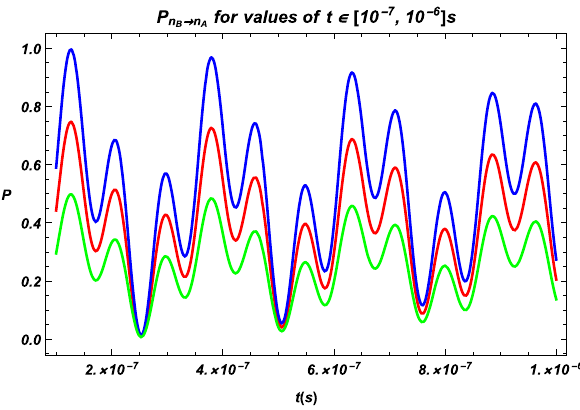
Fig. 1 Plots of P B → A ( t ) , for θ = π/ 3 (the red line), θ = π/ 4 (the blue line), θ = π/ 8 (the green line). In the plots, we con- sider n = 4 trapped ions in a harmonic potential, and the follow- ing values of the resonance frequencies of the atomic spins splitting (cid:14)ω / 2 π( MHz ) = − 11 . 8 ; − 3 . 7 ; 3 . 9 ; 12 andofthecouplingconstants i J ij ( Hz ) : J 1 , 2 = J 3 , 4 = 479 ; J 1 , 3 = J 2 , 4 = 349; J 1 , 4 = 273 ; J 2 , 3 =